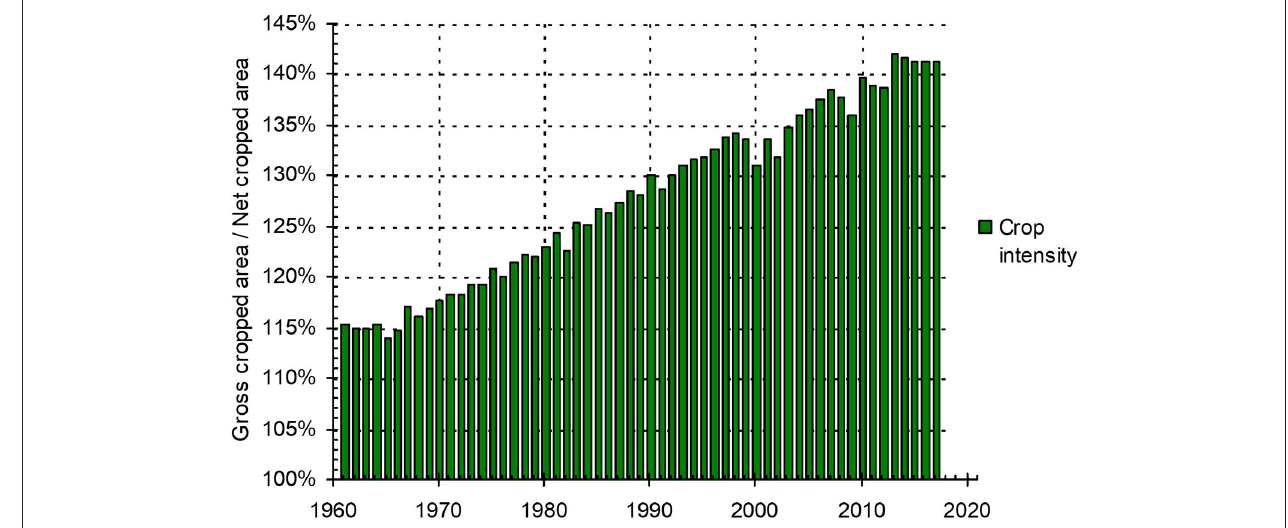
FIGURE 4 | Crop intensity (India, 1961–2017). Source: Dorin, 2020, mostly based on EPWRF